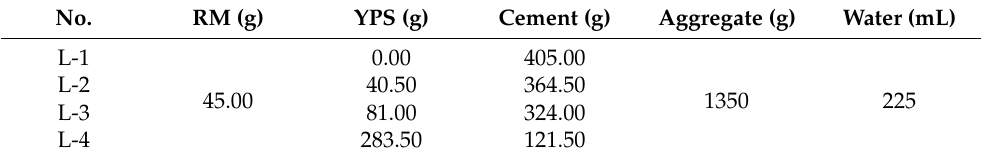
Table 3. The mix design proportions of concrete prepared with RM and YPS (by weight). No. RM (g) YPS (g) Cement (g)